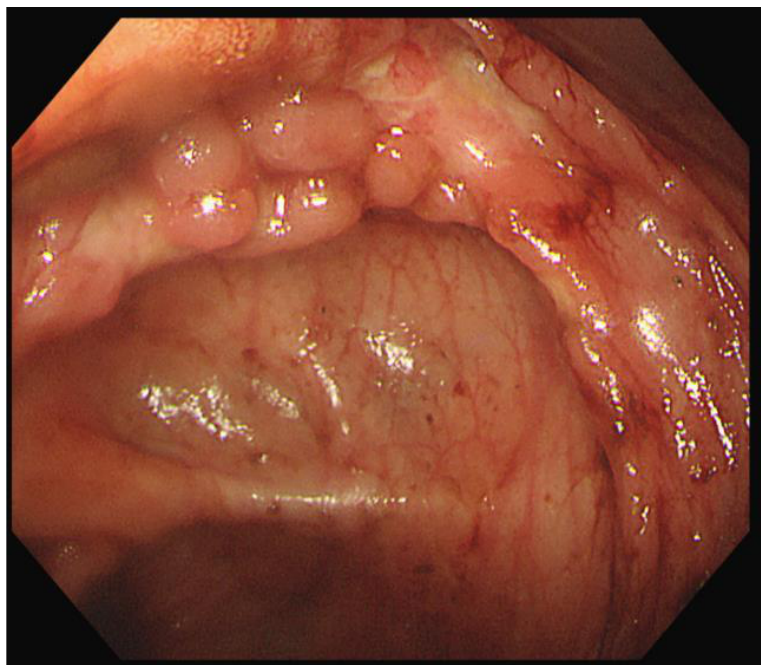
Figure 3. Initial endoscopic findings revealed ulcerations around the ileocecal valve.